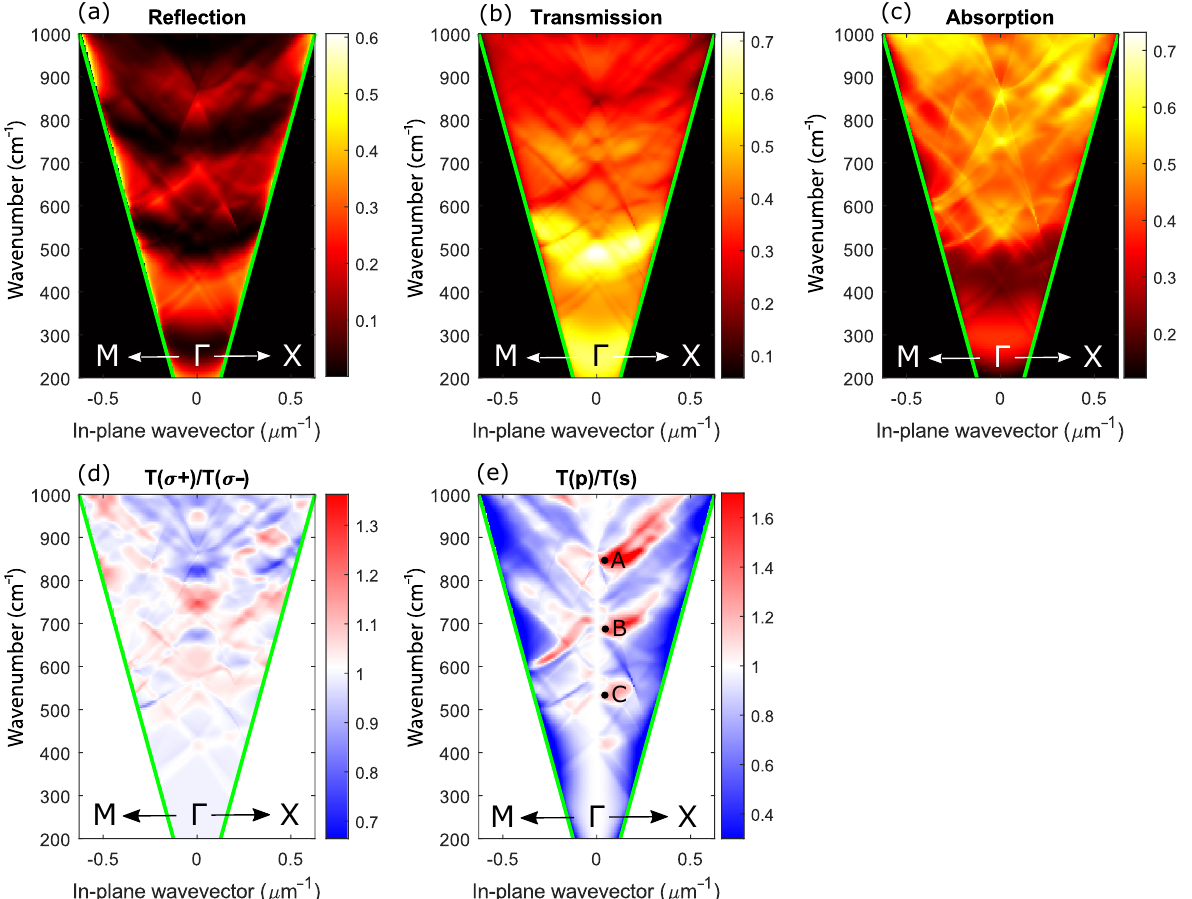
Figure 9. Wavenumber and in-plane wave vector dependence of ( a ) reflection coefficient, ( b ) transmission coefficient, ( c ) absorption coefficient, ( d ) ratio of transmission coefficients in σ + and σ − circular polarizations, ( e ) ratio of transmission coefficients in p and s linear polarizations. Green lines show the air light cones. The above coefficients are calculated along Γ -X and Γ -M photonic crystal directions. ω ( A ) / c ≈ 851cm − 1 , ω ( B ) / c ≈ 690cm − 1 , ω ( C ) / c ≈ 540cm − 1